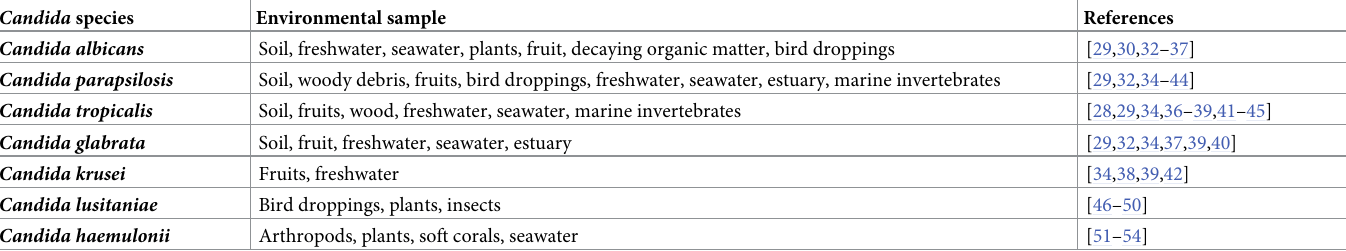
Table 1. Reported isolation of common pathogenic Candida species from environmental